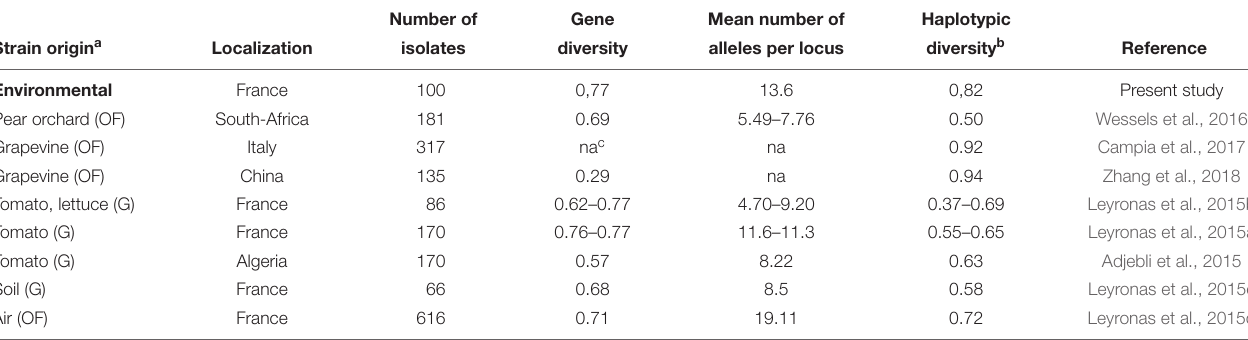
TABLE 5 | Genetic diversity reported for strains of B. cinerea collected from different origins and characterized using the same microsatellite markers developed by Fournier et al. (2002), as in this study. Number of Gene Mean number of Haplotypic Strain origin a Localization isolates diversity alleles per locus diversity b Reference